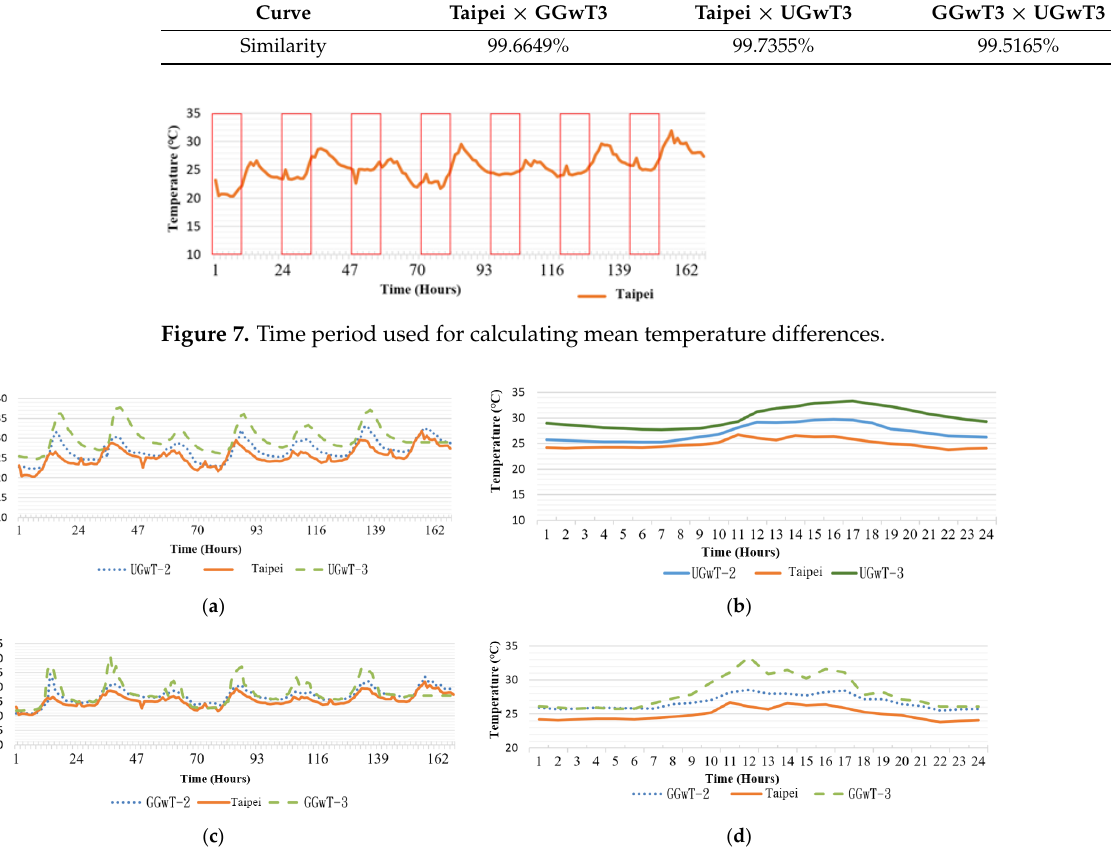
Figure 8. Temperature of Type A and Type B permeable brick pavement ( a ) 10 cm underground ( b ) partial observation on 21 May at 10 cm underground ( c ) above ground ( d ) partial observation on 21 May above ground.